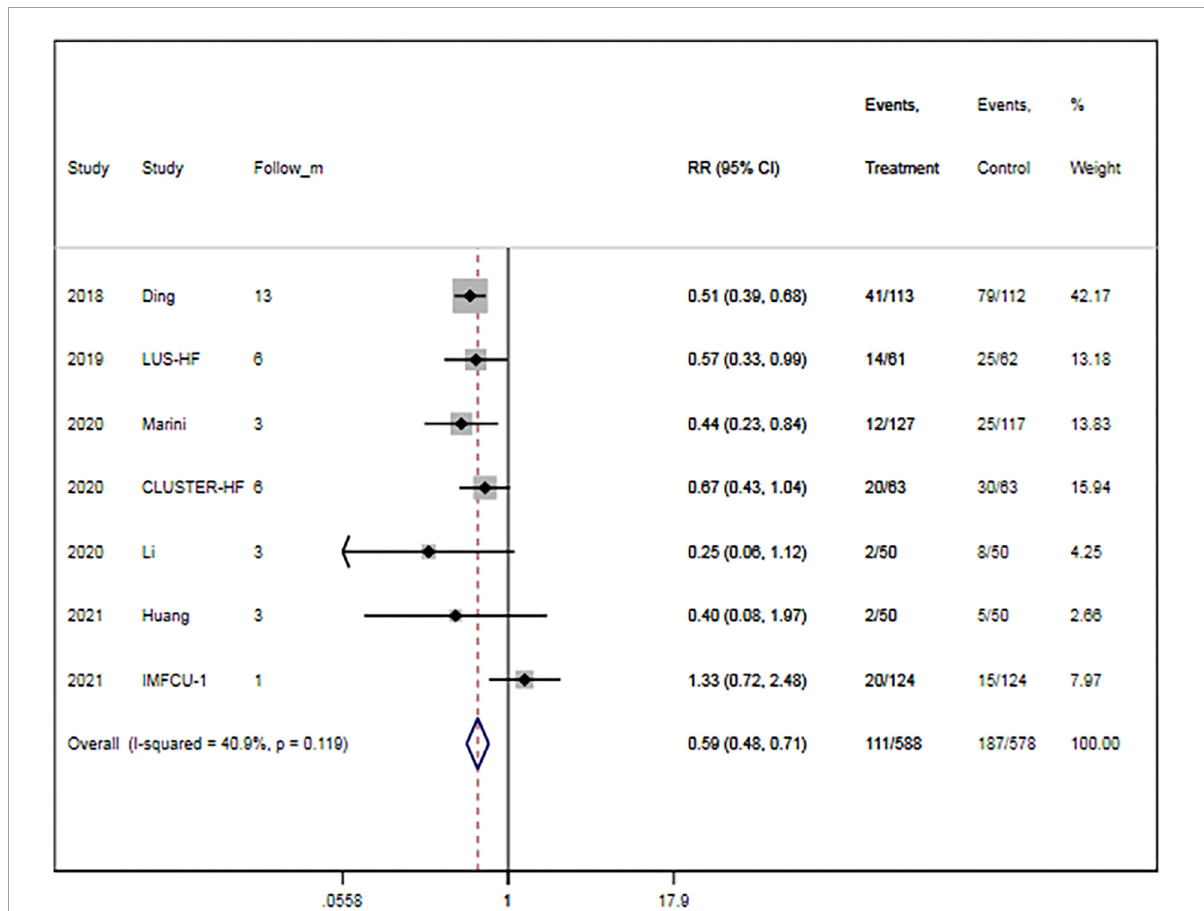
TABLE 3 Primary and secondary outcomes of the lung ultrasound-guided treatment group and the usual care group. Outcomes Num. of event in